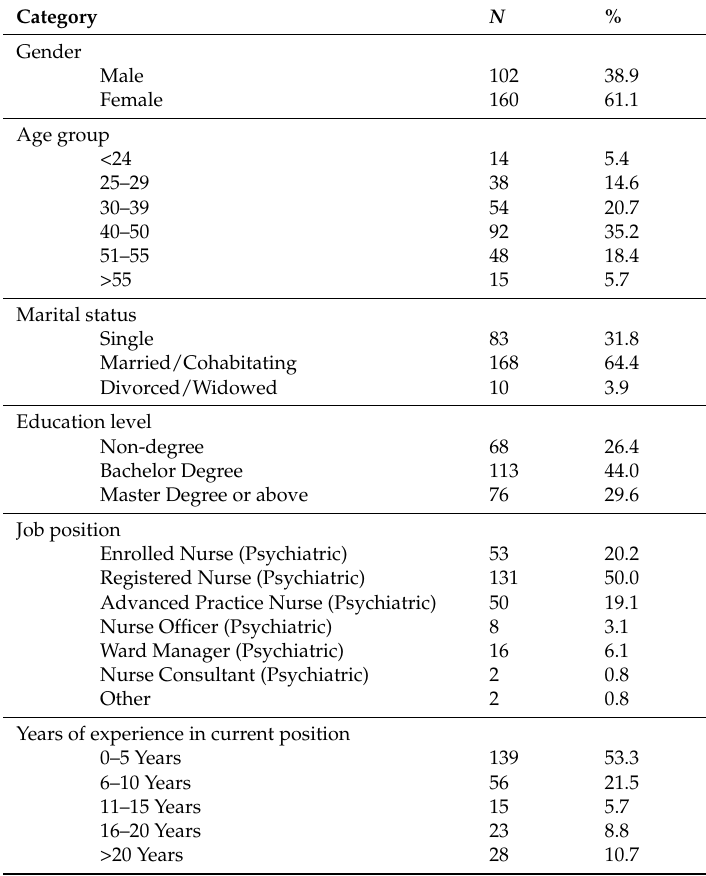
Table 1. Demographic profile and occupation-related characteristics of participants ( N =